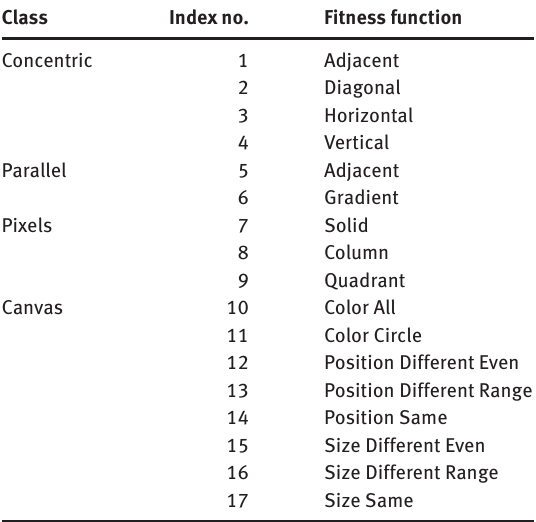
Table 1: Complete List of Fitness Functions. Class Index